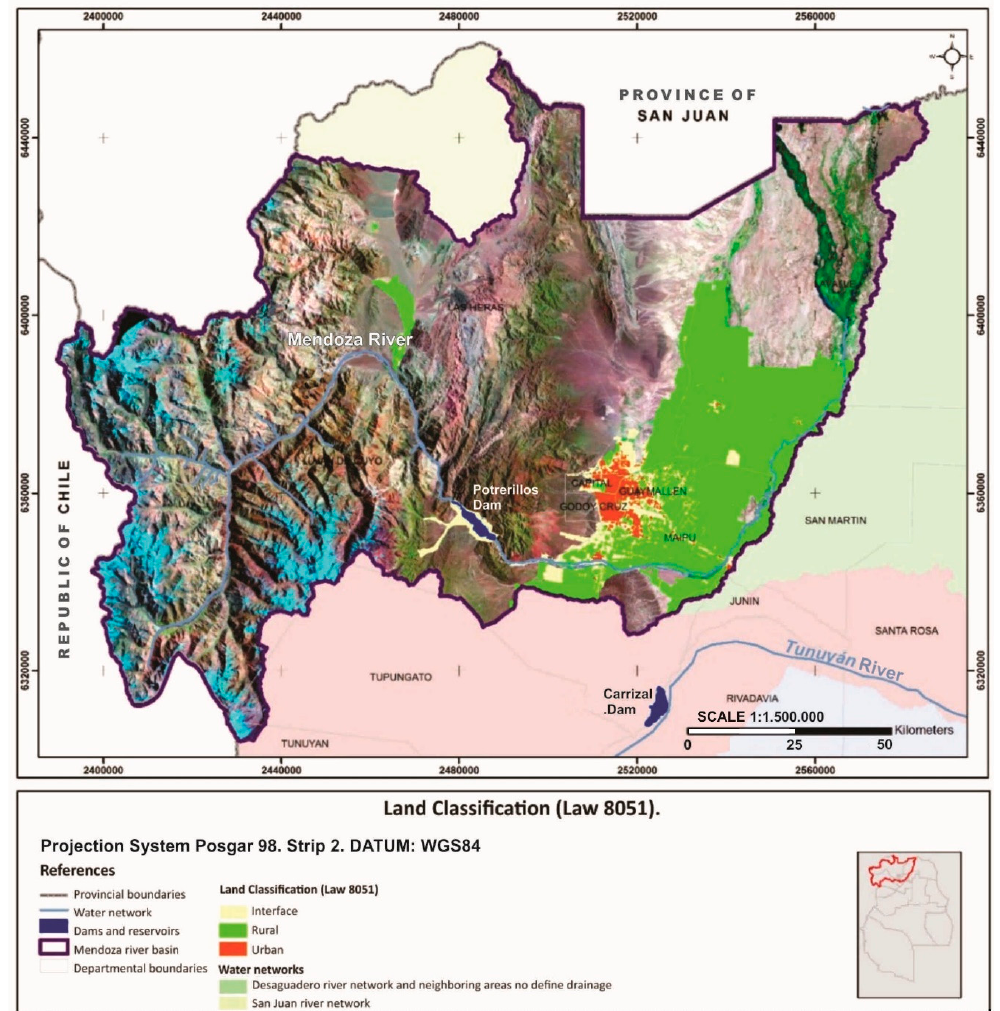
Figure 1. Mendoza River basin [ 5 ].